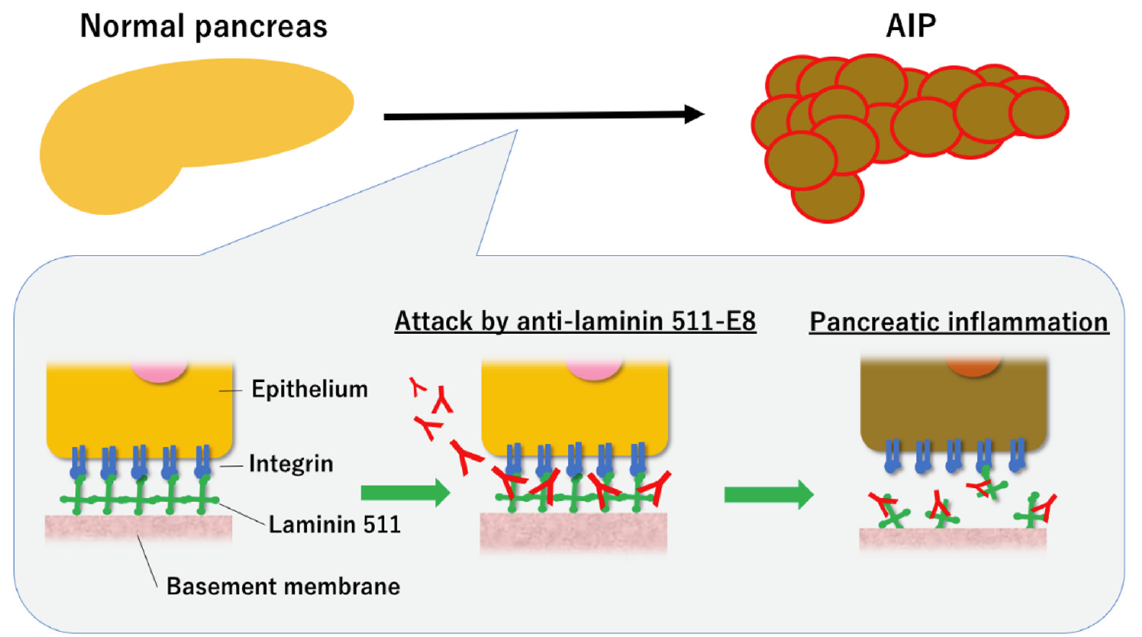
Figure 2. Proposed pathogenetic mechanism of autoimmune pancreatitis (AIP). The binding of specific pathogenetic autoantibodies to the basement membrane causes pancreatic inflammation, leading to AIP.